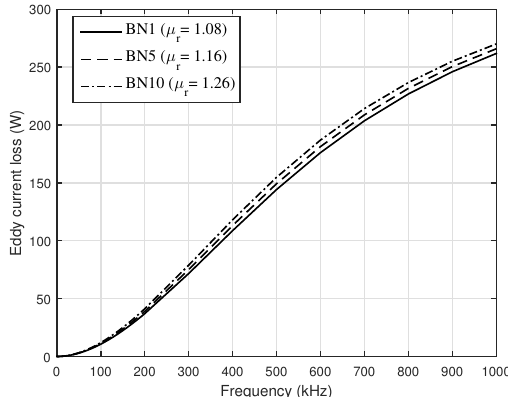
Figure 7. Magnet eddy current losses vs. frequency for bonded NdFeB classes (same conductivity of 0.01 MS/m